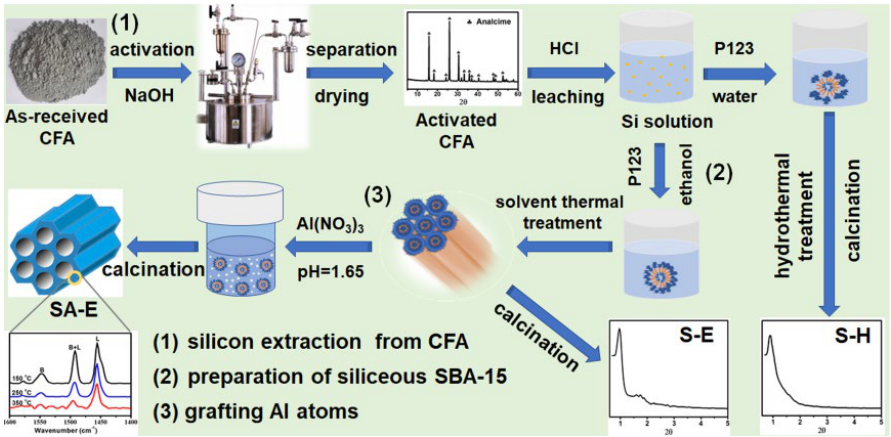
Figure 1. Schematic illustration for the synthesis of mesoporous materials of S - H, S - E, and SA - E. Silicon extraction was performed through a subcritical hydrothermal method. The as- received CFA (10 g) was mixed with 120 mL of NaOH solution (0.5 mol/L) in an autoclave reactor, and the mixture was reacted at 250 ◦ C with a pressure of 400 kPa for 2 h under stirring (500 rpm). The activated CFA was collected by filtration, washed, dried in air, and dispersed in 140 mL of 2.5 M HCl solution. After vigorously stirring at 45 ºC for 1.5 h, the supernatant silicon-rich solution was obtained using a filtration and separation process, which was used as silicon precursor for the synthesis of mesoporous silica